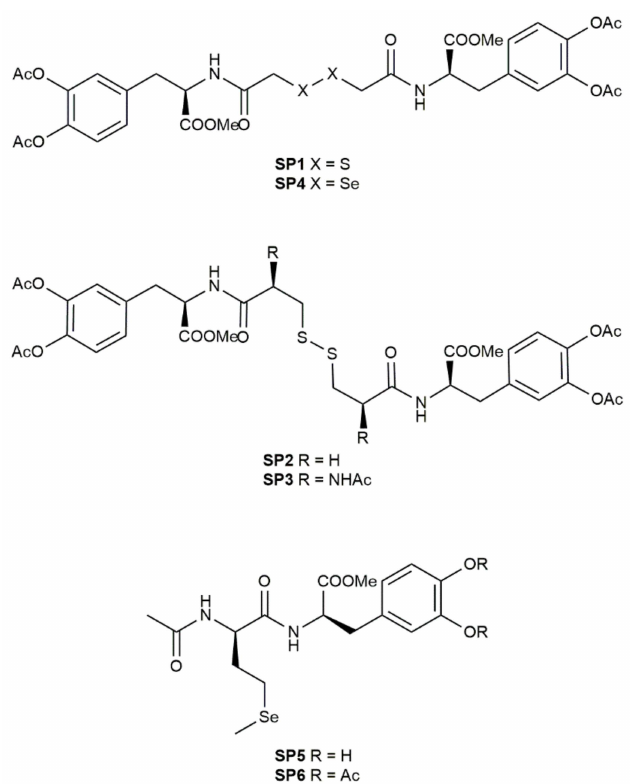
Figure 1. Chemical structures of novel selenyl- and sulfur-L-Dopa derivatives ( SP1-6